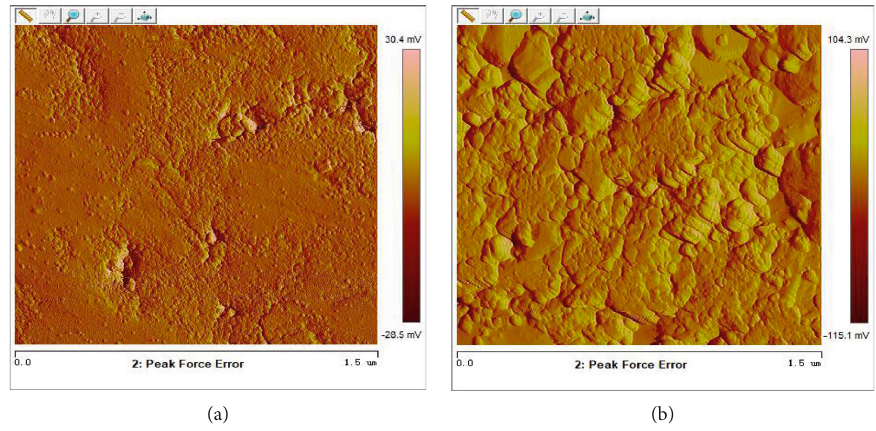
Figure 14: The surface of calcite. (a) Carbonation. (b) Mineralization by